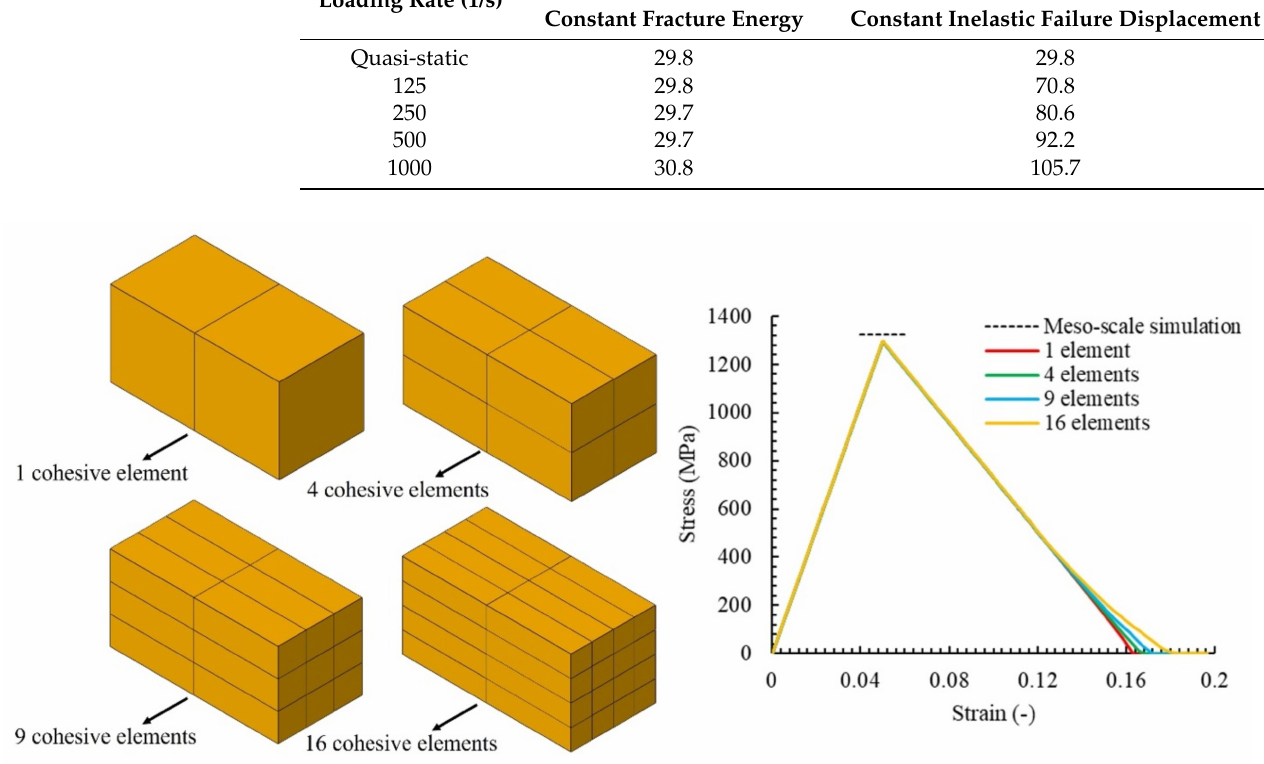
Figure 7. Mesh sensitivity analysis of the tensile load